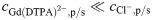
Presentation of the experimental and theoretical model systems.(A) The model system at different times. The polymer is negatively charged. At t < 0 there is thermodynamic equilibrium between the two solutions. At time t = 0, Gd(DTPA)2− is added to the salt solution and is allowed to flow over the semipermeable membrane into the polyelectrolyte solution. In the system cGd(DTPA)2−,p/s≪cCl−,p/s, cNa+,p/s, FCD (the subscripts p and s denote polyelectrolyte- and salt-solution, respectively). Moreover, because the polymer is negatively charged, the following will be true: cGd(DTPA)2−,p<cGd(DTPA)2−,s, cCl−,p<cCl−,s and cNa+,p>cNa+,s. (B) Schematic drawing of the sample holder used in the μMRI experiments. (C) Cross section of the sample holder in the x-y plane with indicated dimensions. (D) Chemical structure of Gd(DTPA)2− [6]. (E) Chemical structure of carboxymethylcellulose (CMC).